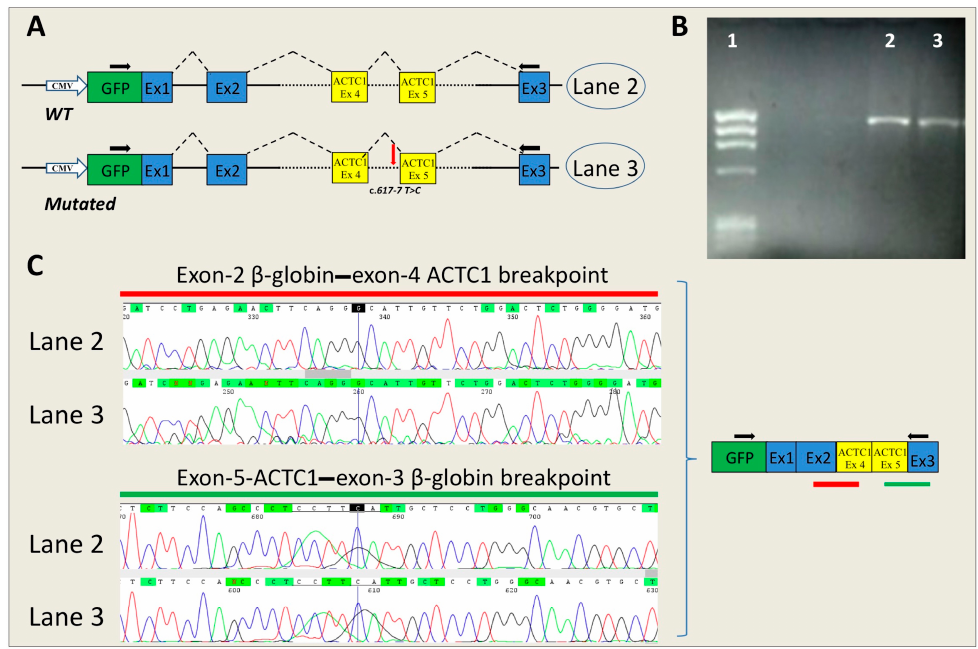
Figure 3. Effect of the ACTC1 ‐ c.617 ‐ 7T>C mutation on the splicing mechanism. ( A ) Schematic representation of the splicing process in pMGene ‐ ACTC1 constructs (WT, upside; mutated, downside). The red arrow shows the position of the mutation. The blue boxes represent the exons of human β‐ globin, the yellow boxes represent the ACTC1 exons cloned in the pMGene vector. The black arrows indicate the primers used for PCR analysis; ( B ) RT ‐ PCR analysis of mRNA extracted from cell lines transfected with pMGene ‐ ACTC1 (WT or mutated). Lane 1 : Marker IX (Roche Diagnostics); Lane 2 , pMGene ‐ ACTC1 ‐ WT; Lane 3 : mutated pMGene ‐ ACTC1 ; ( C ) Electropherograms obtained from the DNA sequencing of fragments shown in panel B and relative splicing results (Black, red, green and blue peaks represent the G, T, A, and C bases, respectively). The blue lines in the electropherograms show the end of exon 2 of β‐ globin (upside) and the end of exon 5 of ACTC1 (downside). The green and red lines show the position of the reported sequences. SCN5A ‐ c.393 ‐ 5C>A. The analysis of the RNA obtained from the minigene system showed the generation of an alternative transcript in pMGene ‐ SCN5A ‐ c.393 ‐ 5C>A generated from the skipping obtained from the pMGene ‐ SCN5A ‐ WT (Figure 4). The skipping of exon 4 causes the in ‐ frame deletion of 30 amino acids in the protein (Na v 1.5 ‐ L132_E161del). The deletion is located in the S1 transmembrane segment of the DI domain [25].